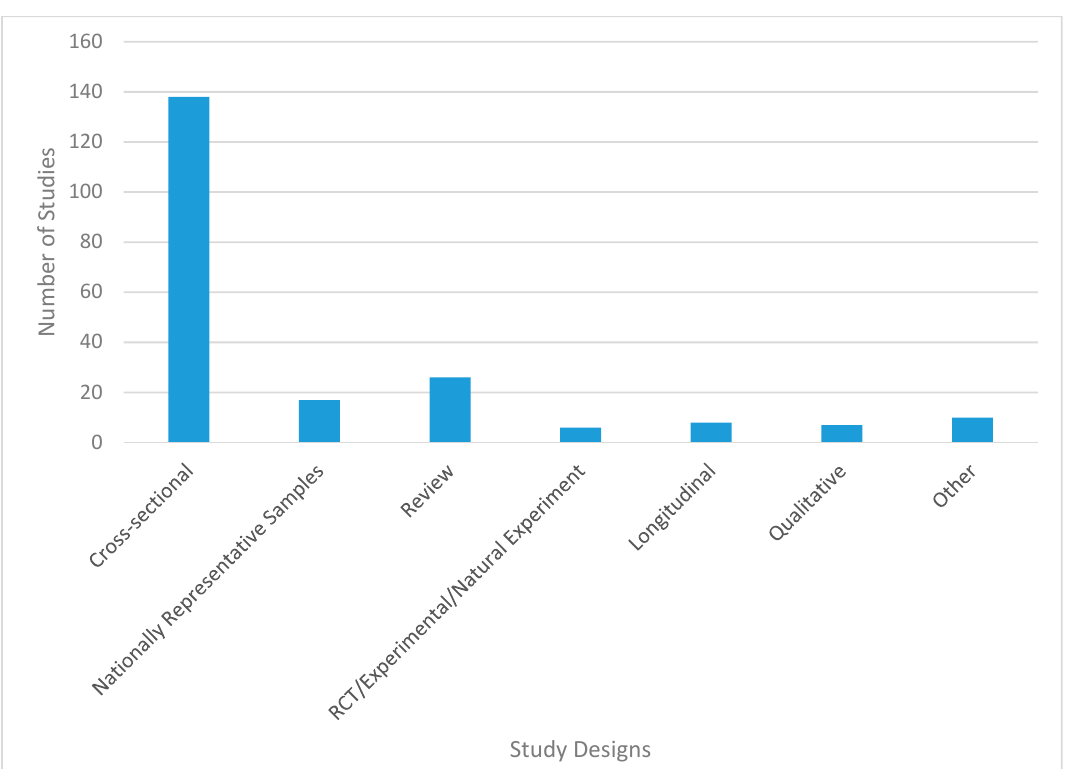
Figure 3. Distribution of studies considered in this review by study design.